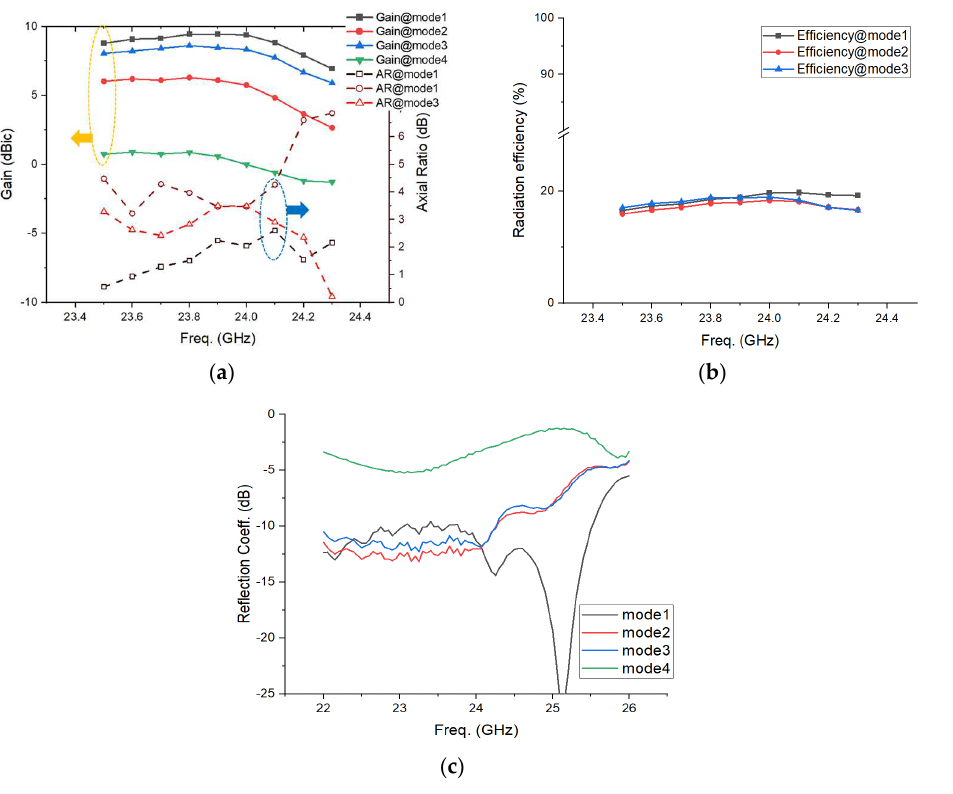
Figure 15. ( a ) Gain, AR, ( b ) efficiency, and ( c ) reflection coefficient of the designed antenna for each mode.